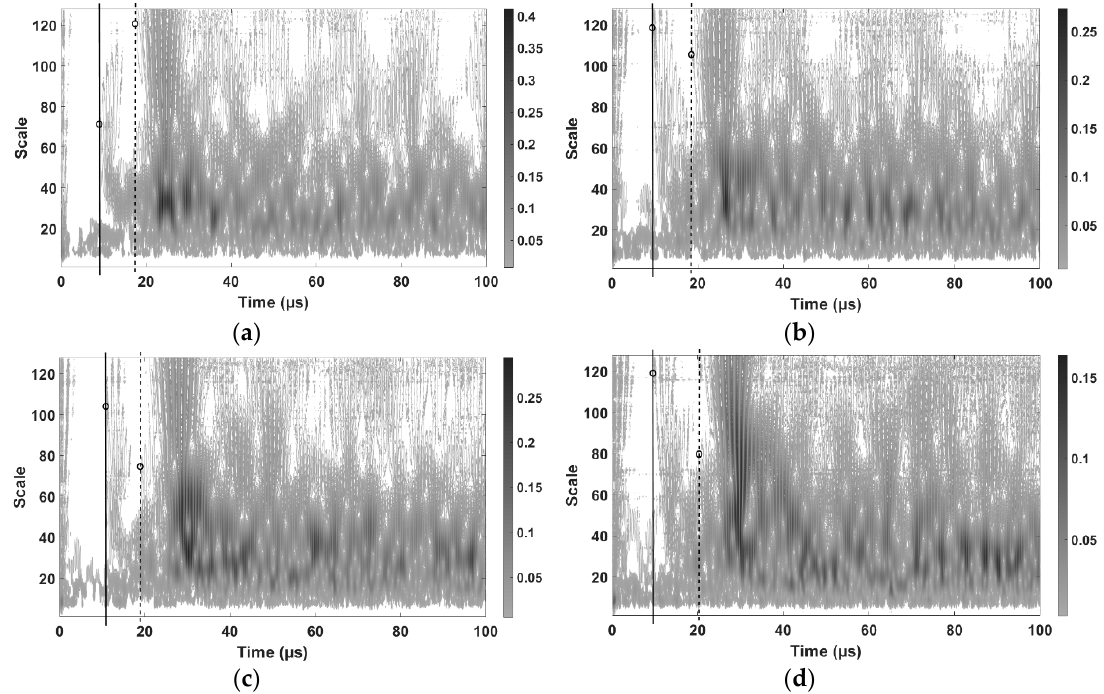
Figure 5. Time-frequency maps of ultrasonic waves induced at different scan points. The dotted line, represents direct ultrasonic wave arrival, the solid line, ultrasonic defect-reflected echo arrival. The corresponding ultrasonic transducer position is x = 15 mm and y = 110 mm, and the positions of laser scan points are: ( a ) x = 11 mm and y = 71 mm ( b ) x = 11 mm and y = 51 mm. ( c ) x = 31 mm and y = 41 mm. ( d ) x = 81 mm and y = 41